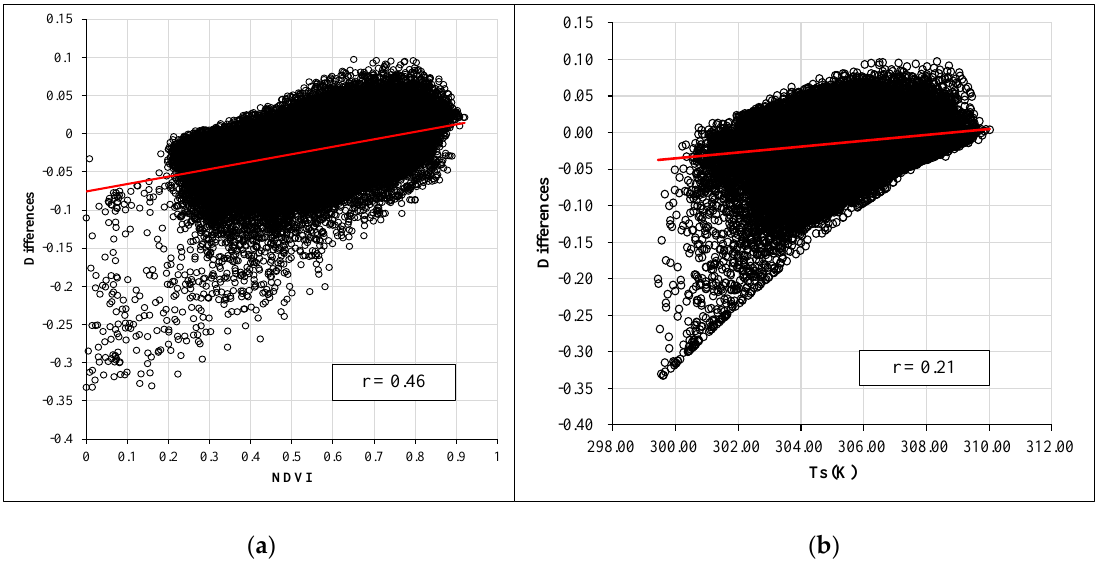
Figure 10. Scatterplots of the differences in EF retrieved from the TPS and NPS versus NDVI ( a ), and scatterplots of the differences in EF retrieved from the TPS and NPS versus T s ( b ).